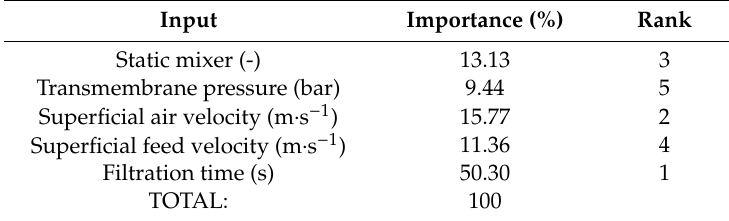
Table 4. Relative importance of the input variables for Bacillus velezensis broth